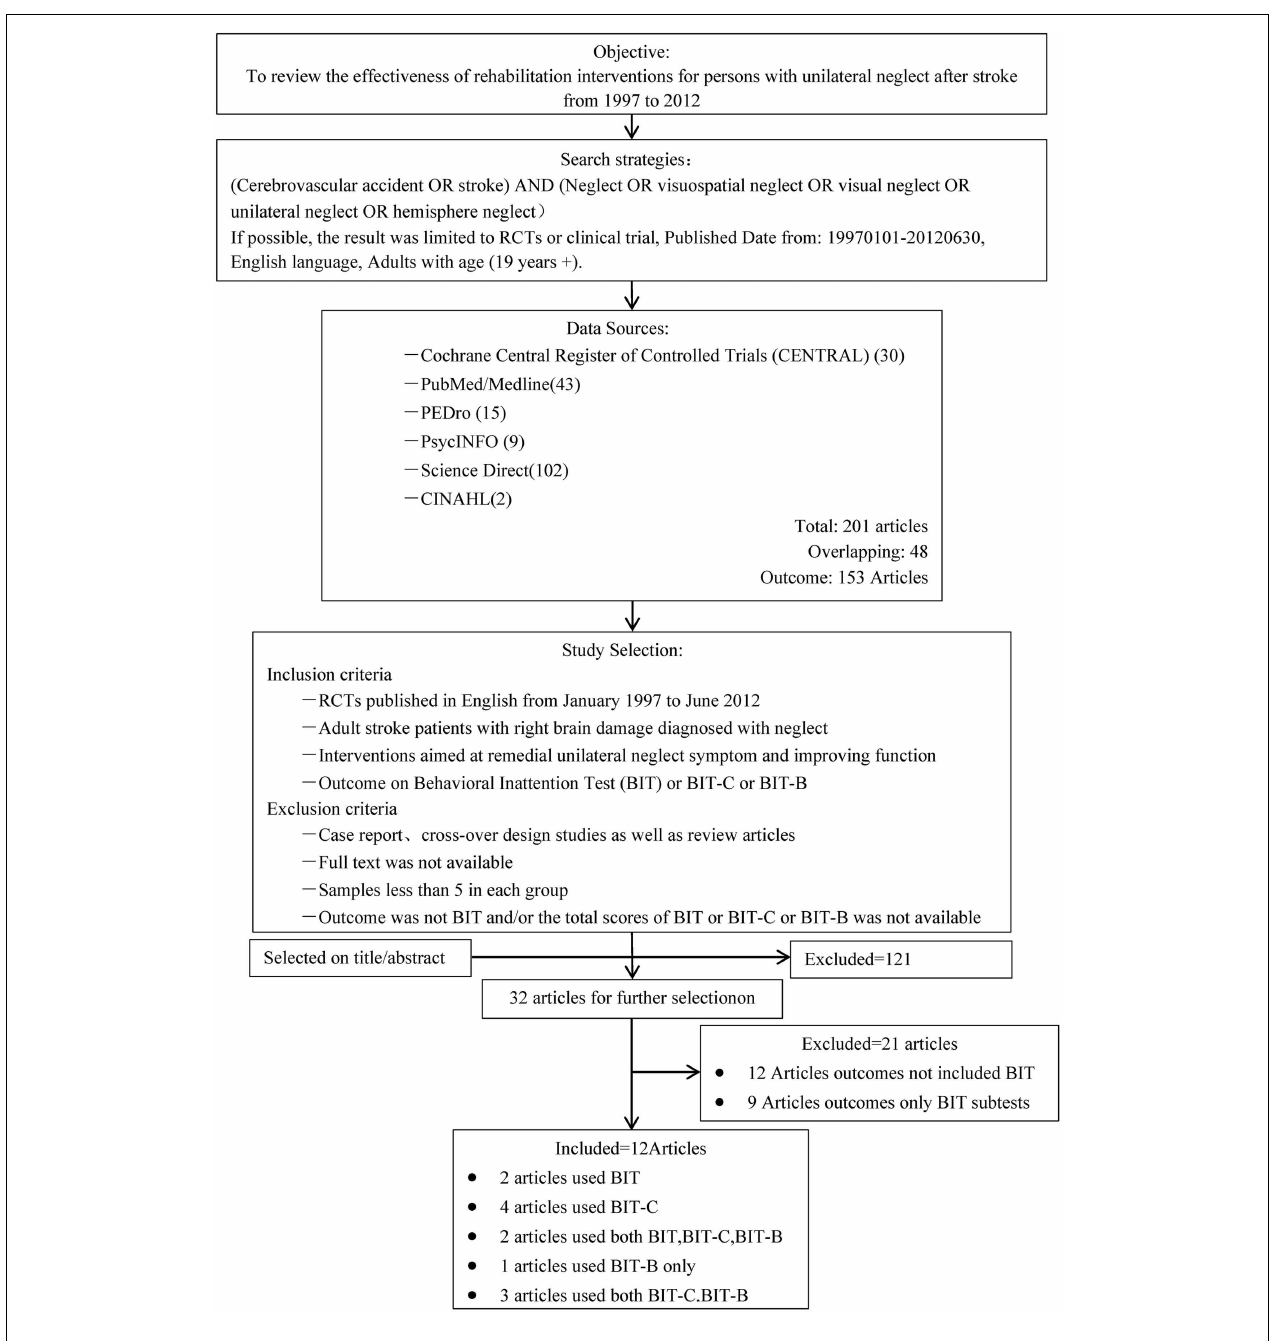
FIGURE 1 | Overview of the search and selection process